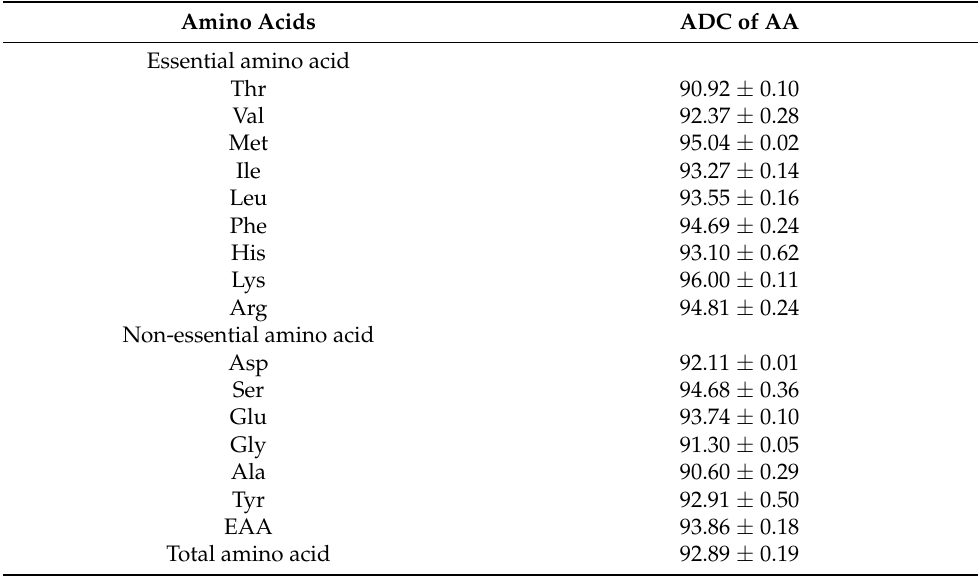
Table 5. ADC (%) in TM of AA in largemouth bass.